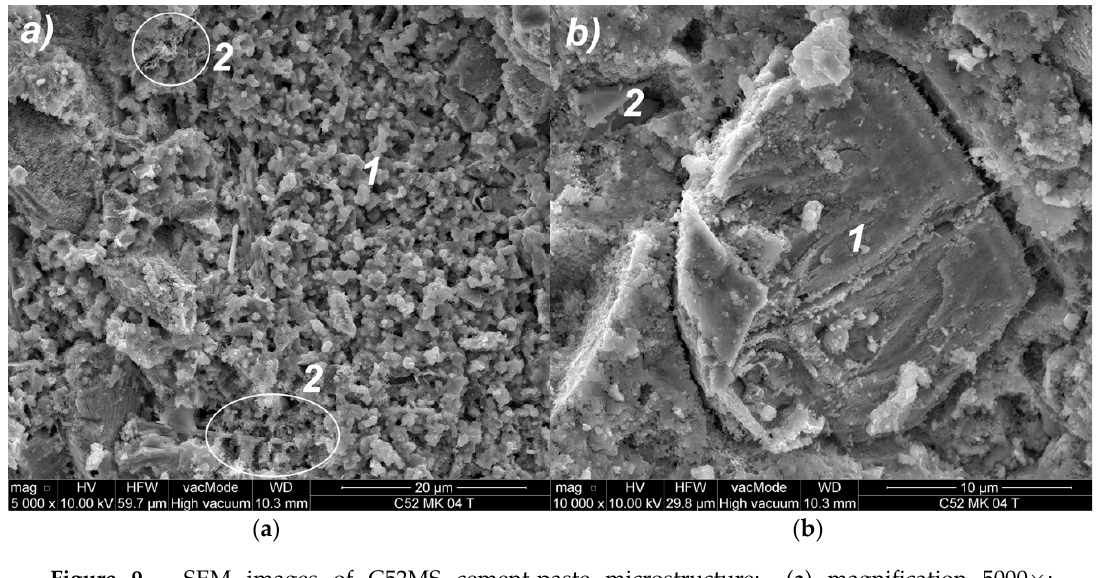
Figure 9. SEM images of C52MS cement-paste microstructure: ( a ) magnification 5000×; ( b ) magnification 10,000×; descriptions of the indications in the text. Table 5. Composition of the cement pastes tested after the thermal interaction, together with a percentage difference in the mass content of individual components, with respect to the C52 sample.